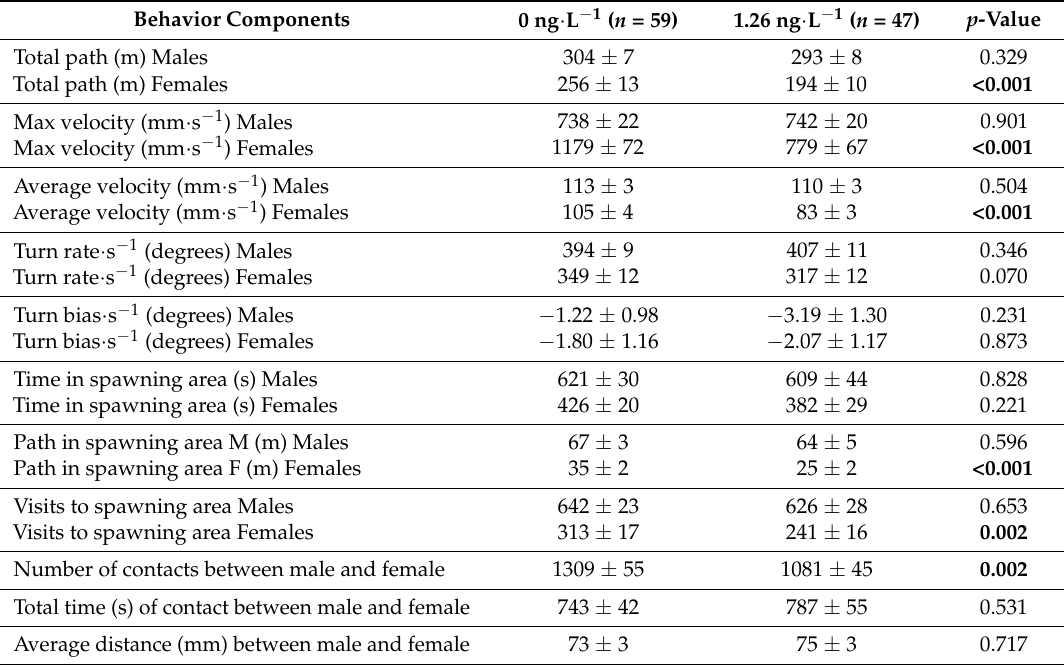
Table 3. Differences in reproductive behavior in non-spawning zebrafish pairs where the males were exposed to 0 and 1.26 ng · EE2 · L − 1 ,